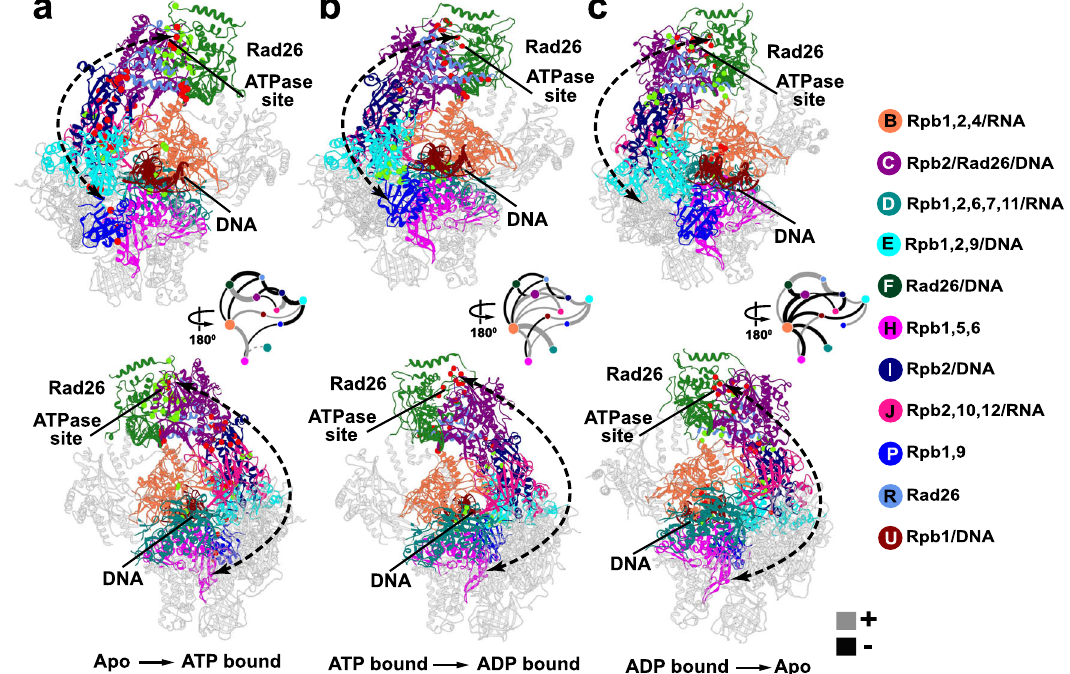
Fig. 5 Discovery of an extended allosteric communication path through the Pol II – Rad26 complex from dynamic network analysis. Dynamic communities directly traversed by the allosteric path (black dotted arrow) are shown in color. dCNA subgraphs for these communities of the Pol II – Rad26 complex are shown as insets, indicating gain( + )/loss( − ) of dynamic contacts for the following transitions: ( a ) apo to ATP; ( b ) ATP to ADP; ( c ) ADP to apo. Non-participating communities are shown in gray. Red and green spheres denote residues with highest gain/loss of contact probability mapped onto the Pol II – Rad26